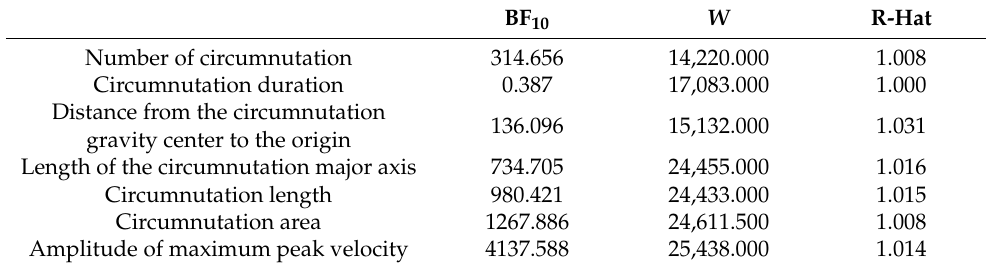
Table 2. Two-sided Bayesian Mann–Whitney U test for the DS and the SS